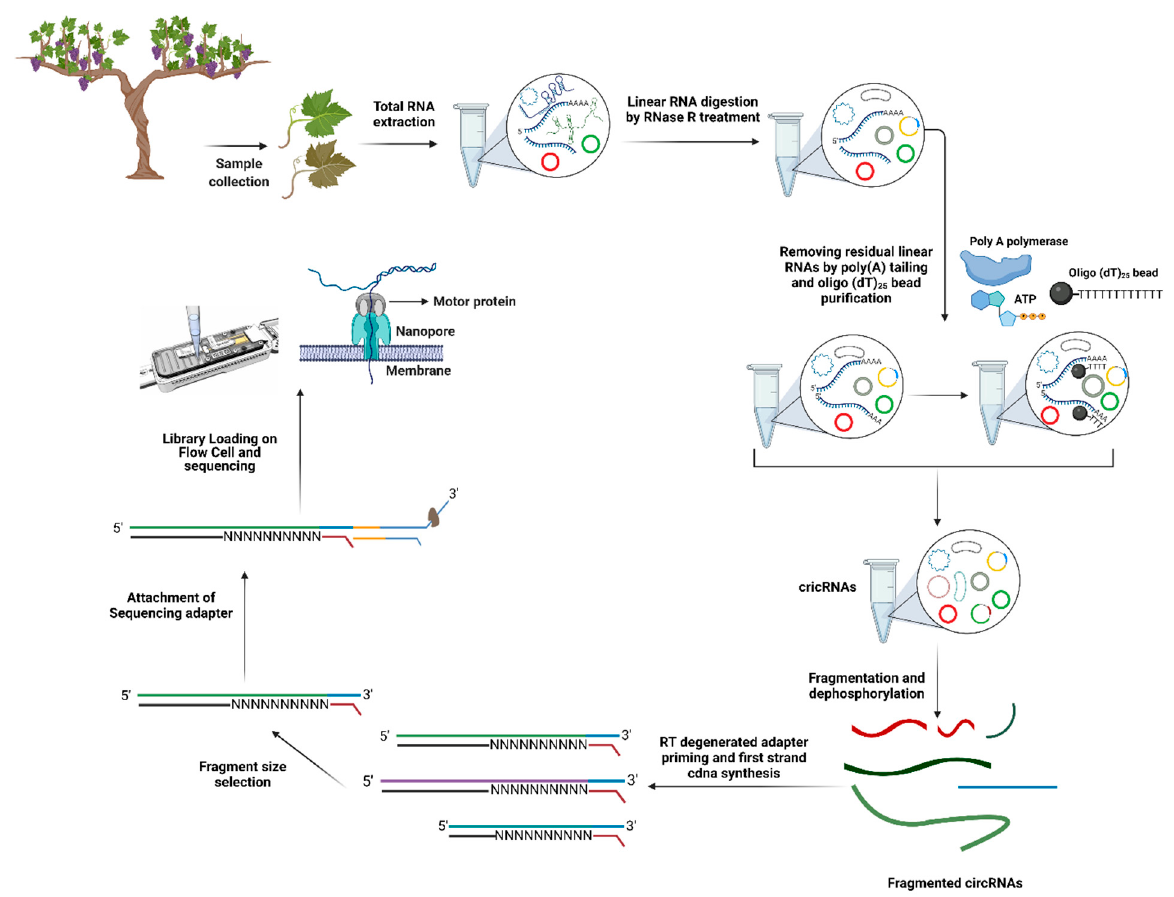
Figure 4. Detection of circular RNAs, viroids, and virusoids in infected grapevine samples by nanopore direct RNA sequencing. Created with BioRender.com (accessed September 15th 2021).